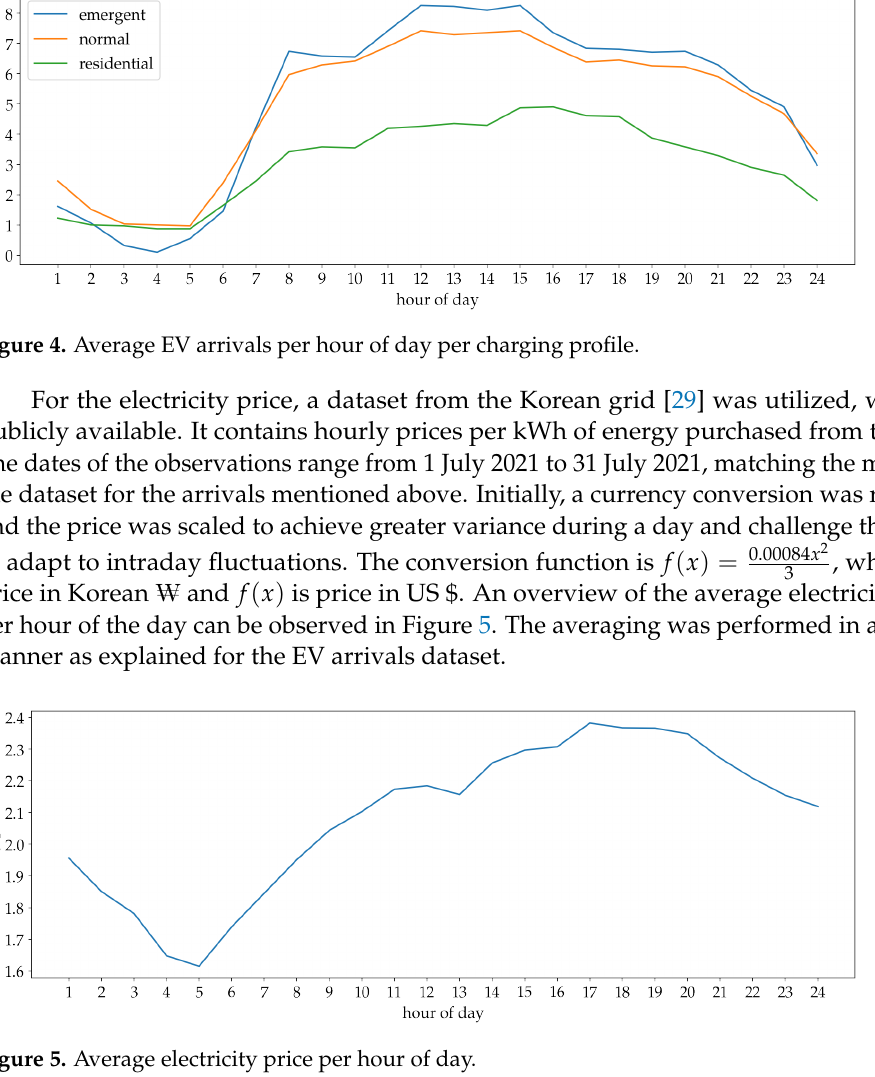
Figure 5. Average electricity price per hour of